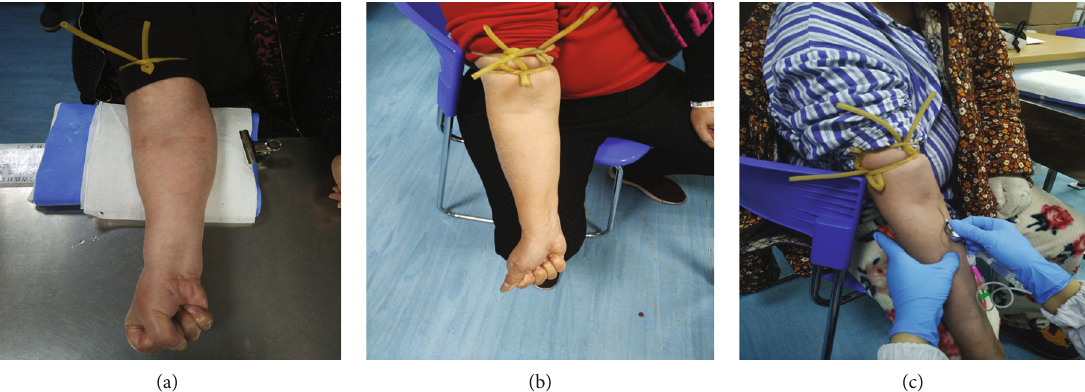
Figure 1: Diagram of di ff erent ligation and puncture methods. (a) Traditional peripheral venipuncture; (b) operation diagram of the new peripheral venipuncture; method (c) operation diagram of the new puncture method for di ffi cult